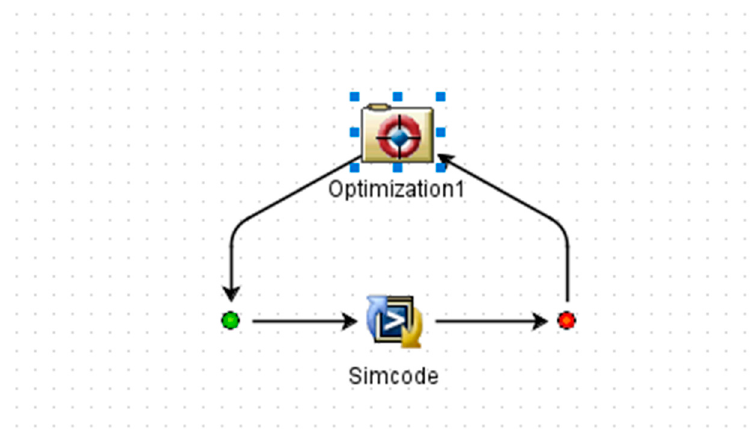
Figure 8. ISIGHT work fl ow